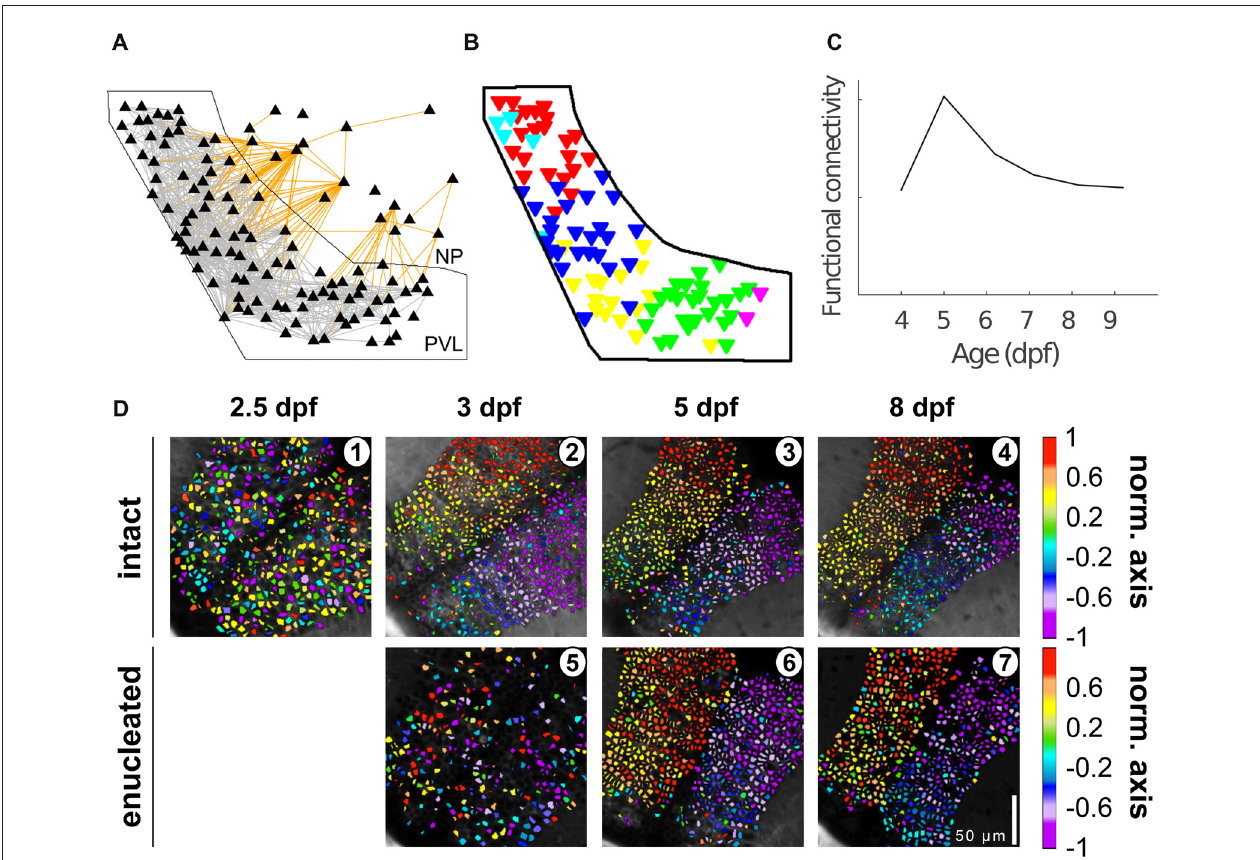
FIGURE 3 | Tectal functional connectivity and neuronal assembly characteristics change over development. (A) Representation of the optic tectum as a graph. Each node (triangle) represents a neuron, and each edge represents correlation exceeding a threshold, i.e., functional connectivity between two neurons (gray lines for intra-PVL edges and orange lines for edges involving NP neurons). The solid black outline shows the boundary of the PVL. (B) Six communities (color coded) were detected in the graph presented in (A) . (C) Functional connectivity metrics peaked at 5 dpf and declined afterwards. (D) Examples of the spatial organization of the spontaneous activity along the caudo-rostral axis of an intact (1–4) and enucleated larva (5–7) at different developmental stages. Scale bar represents 100 mm. Color bar: position along the caudo-rostral axis (the neurons are color coded according to the centroid azimuthal position of the assembly to which they belong; reproduced with permission from Avitan et al., 2017; Pietri et al.,